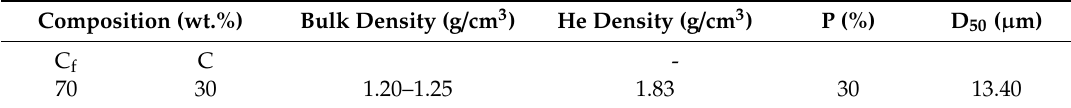
Table 2. Results of the characterization of the C f / C preform. Composition (wt.%)